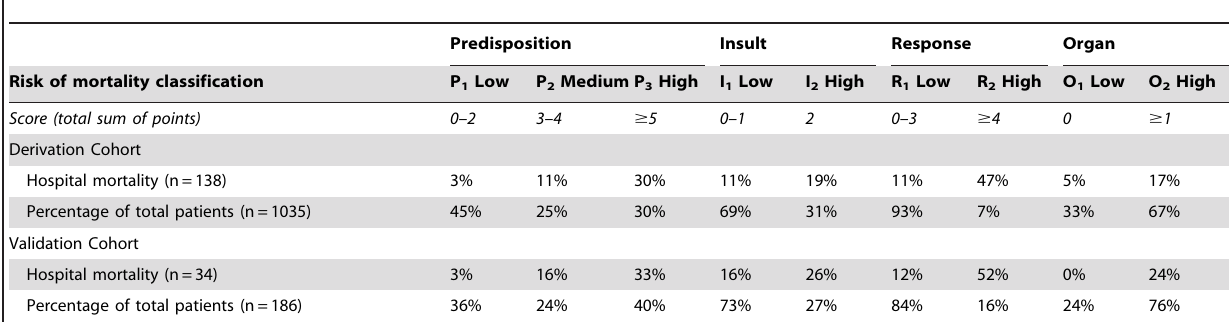
Table 6. Risk of hospital mortality according to the total score of each PIRO